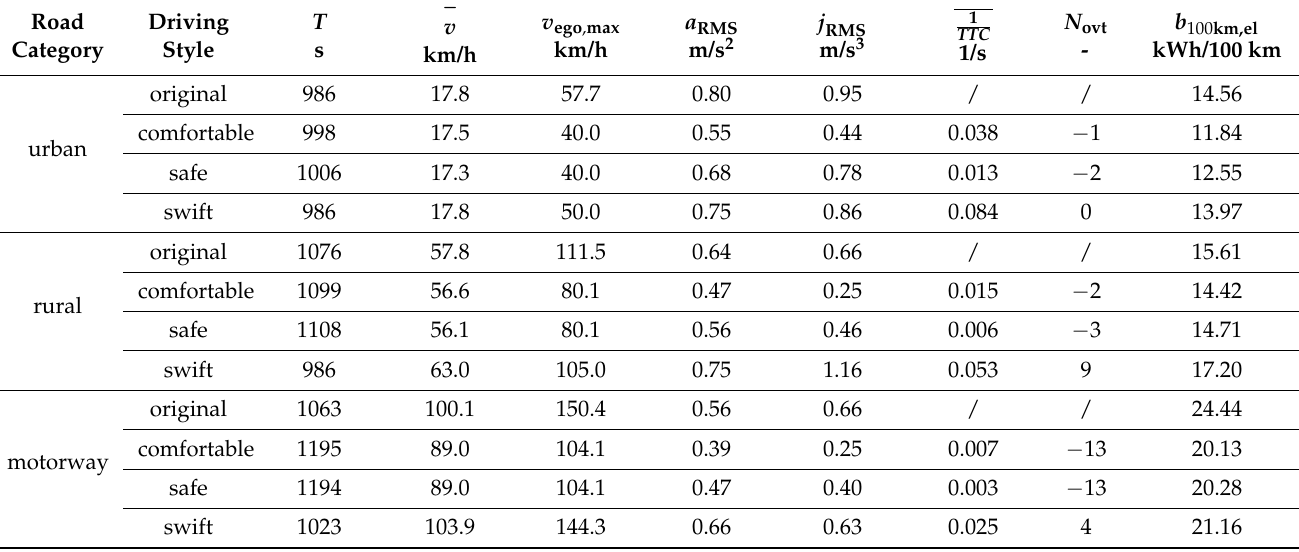
Table 7. Evaluation attributes of the cycles with different driving